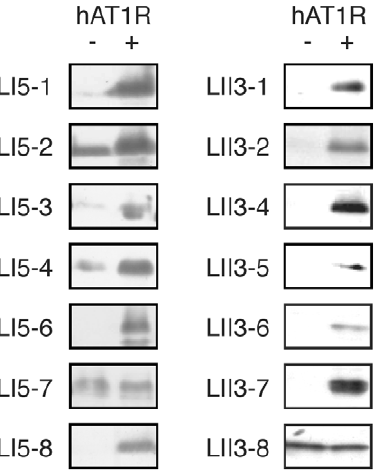
Figure 6. Binding assays of selected peptides from the random- ized libraries with the hAT1R-expressing cells. Selected streptavi- din-fused peptides were generated by the PURE system. An aliquot of the reaction mixture was incubated with the hAT1R/CHO-K1 cells (hAT1R + ) or the Mock/CHO-K1 cells (hAT1R 2 ). The cells were washed, and the bound molecules were detected with anti-T7 ? tag antibody. The sequences of the peptides are shown in Figures 4A and 5A.